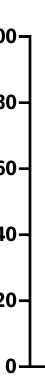
Figure 2. Percentage of cholesterol capacity efflux at baseline (white bar) and 24 h following LPS infusion (grey bar) (n = 8). Data are presented as means ± SEM. Significantly different from baseline (* p < 0.05). Values are expressed relative to those of a plasma pool of healthy volunteers, which was set at 100%.